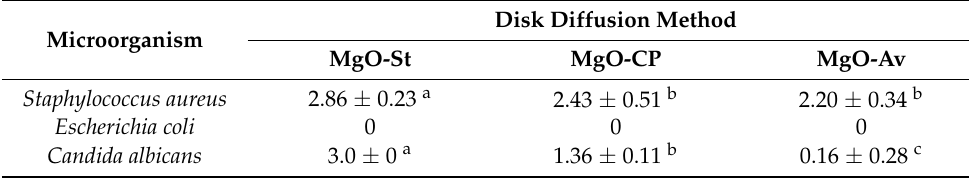
Figure 5. Photographs of halos of inhibition formed in tests against Staphylococcus aureus . *MgO-CP (labeled as 1,2,3); MgO-Av (labelled as 4,5,6); MgO-St (labeled as 7,8,9). Table 2. Average mean zones of inhibition (in mm) produced by synthesized MgO samples on the test organisms.